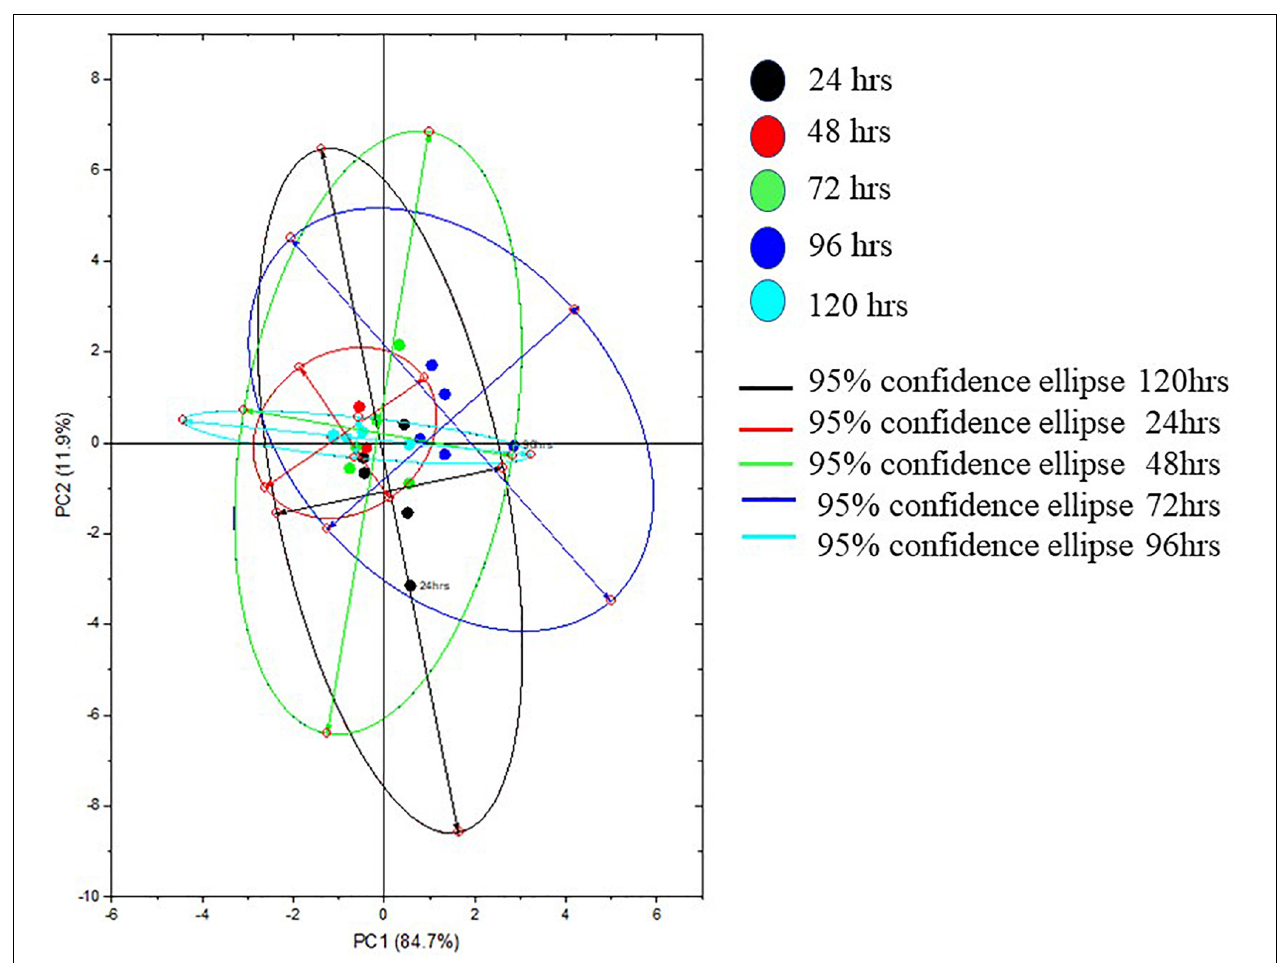
FIGURE 6 | Representative principal component plot from SERS spectra of biofilms formed by E. cloacae SBP-8 grown from 24 to 120